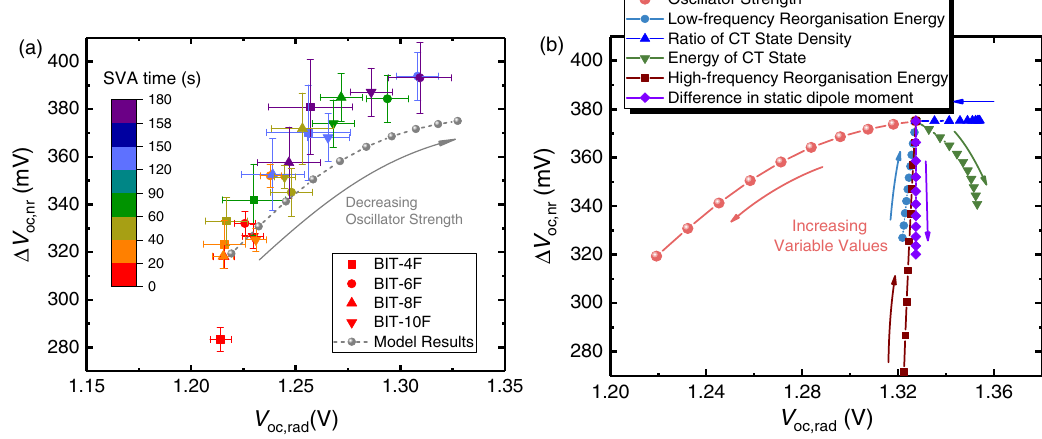
FIG. 4. (a) Calculated (experimental) nonradiative voltage losses ( Δ V ) as a function of V with respect to different exposure oc ; nr oc ; rad times in solvent vapor for BIT-4F-, 6F-, 8F-, and 10F-based fullerene solar cells (colored symbols) and simulated (modeled) results considering solely the change of transition oscillator strength (gray dashed line with solid circles). (b) The effect of the different parameters of the model on the variation of Δ V with V . The only parameter leading to a strong positive correlation between the oc ; nr oc ; rad two is the oscillator strength. The arrow represents the direction of increasing the specific variable values. The variable ranges are j! 10 − 2 ; 1 (cid:2) , λ 0 . 1 ; 0 . 2 (cid:2) eV, R 10 − 2 ; 10 − 4 (cid:2) , E 1 . 45 ; 1 . 55 (cid:2) eV, λ 0 . 1 ; 0 . 2 (cid:2) eV, and j Δ μ f ¼ ½ 10 ; 30 (cid:2) l ¼ ½ v ¼ ½ osc ¼ ½ CT =E ¼ ½ CT ¼ ½